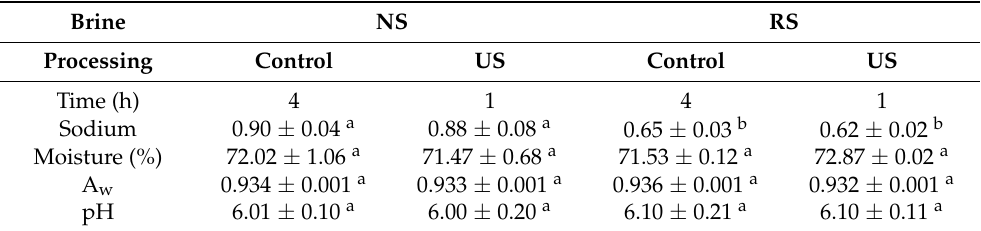
Table 1. Sodium content, moisture, water activity, and pH of pork meat brined with or without ultrasound. Sodium content is express as g of sodium/100 g of meat. Comparisons are between the processing conditions (static brining and ultrasonic (US)) and the brines used for curing NaCl (normal sodium content, NS) and NaCl/KCl (reduced sodium, RS). Brine NS RS